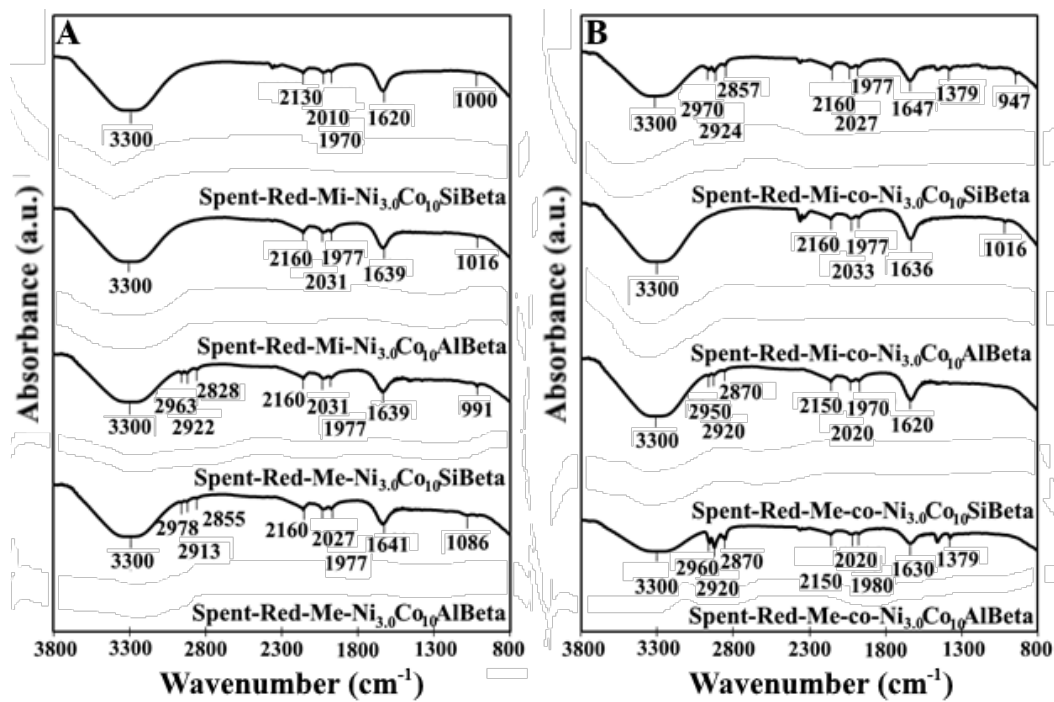
Figure 12. FT- IR spectra of obtained liquid products over ( A ) Spent-Red-Me-Ni 3.0 Co 10 AlBeta, Spent-Red-Mi-Ni 3.0 Co 10 AlBeta, Spent-Red-Me-Ni 3.0 Co 10 SiBeta, Spent-Red-Me-Ni 3.0 Co 10 SiBeta and ( B ) Spent-Red-Me-co-Ni 3.0 Co 10 AlBeta, Spent-Red-Mi-co-Ni 3.0 Co 10 AlBeta, Spent-Red-Me-co-Ni 3.0 Co 10 SiBeta, Spent-Red-Me-co-Ni 3.0 Co 10 SiBeta.